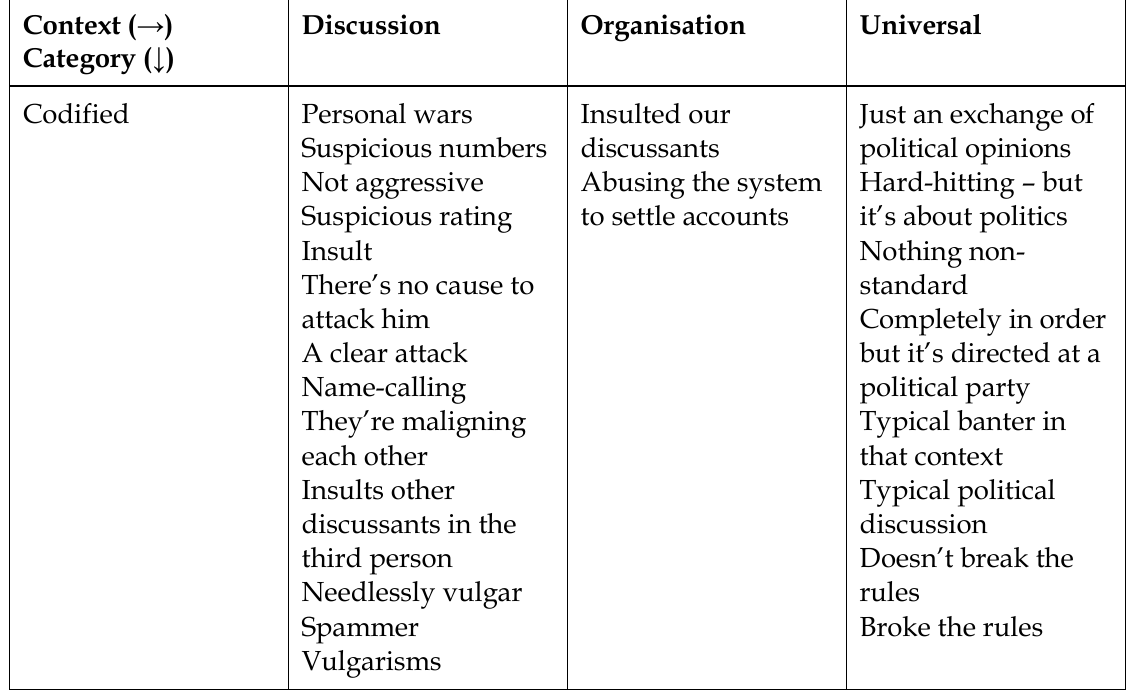
Table 1: The Administrator’s Vocabulary of Evaluation Context (→) Category